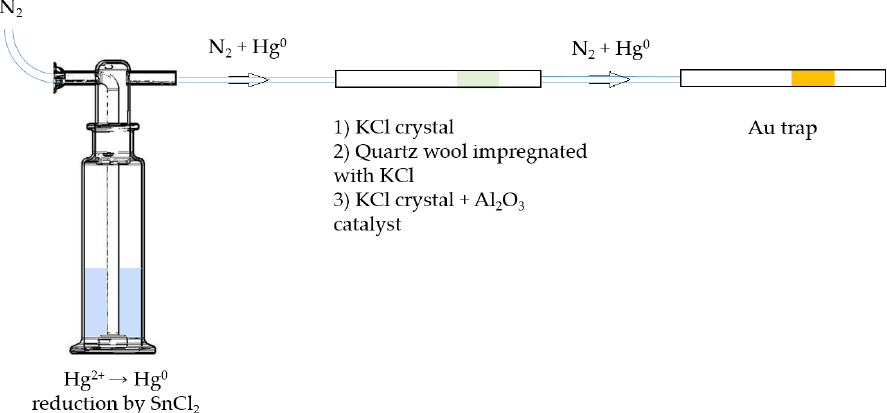
Figure 1. Scheme of the experimental setup for testing the extent of undesirable Hg 0 retention on three different KCl sorbent trap designs (not depicted to scale).